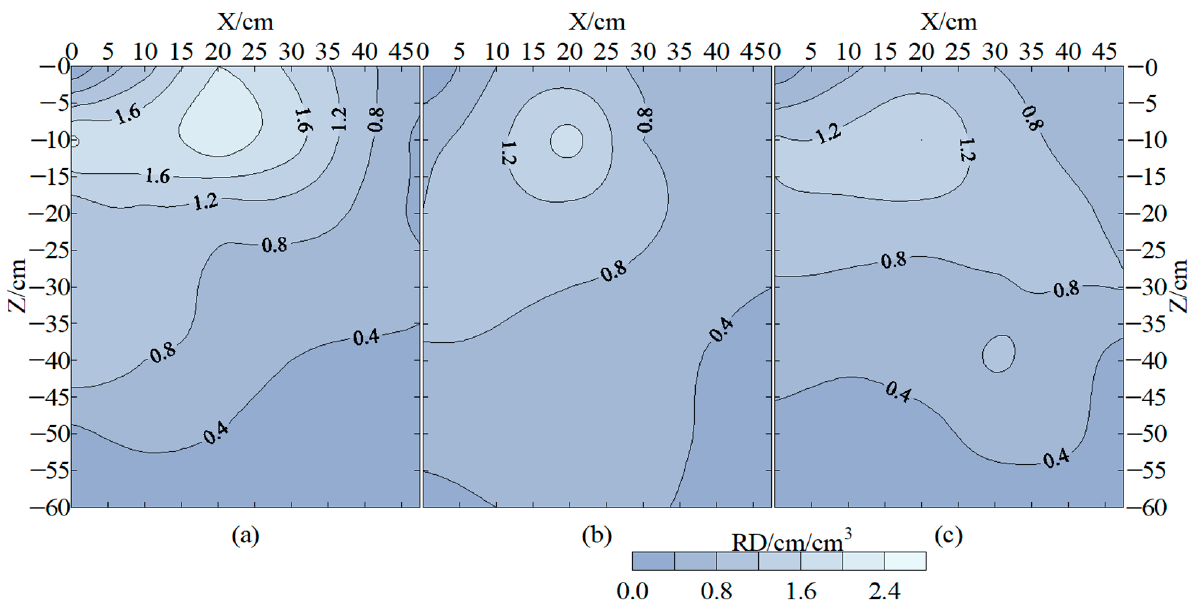
Figure 3. Root length density distribution map. ( a ) Mulched drip irrigation; ( b ) shallow-buried drip irrigation; ( c ) sprinkler irrigation.